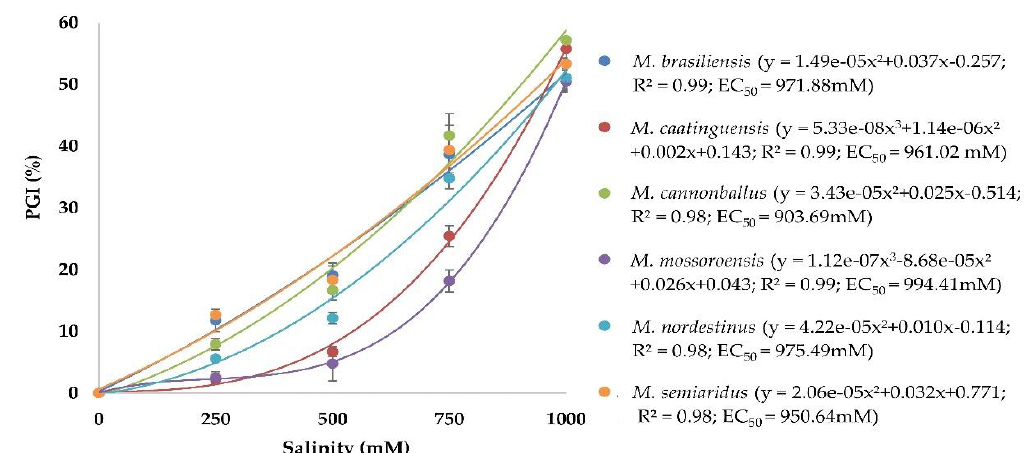
Figure 2. Regression equation, coefficient of determination (R 2 ) and salinity half-maximal effect concentration (EC 50 ) of Monosporascus spp. isolates. y = adjusted with the values of the percentage of growth inhibition (PGI) at NaCl concentrations of 0, 250, 500, 750, and 1000 mM. EC 50 = salinity concentration that inhibits 50% of mycelial growth of Monosporascus spp. calculated from the regression equation (mM).